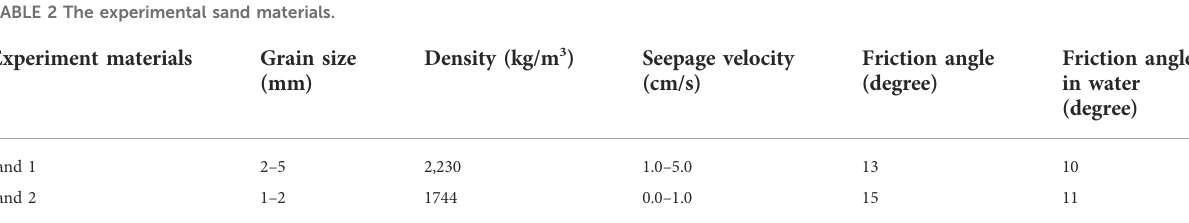
TABLE 2 The experimental sand materials.